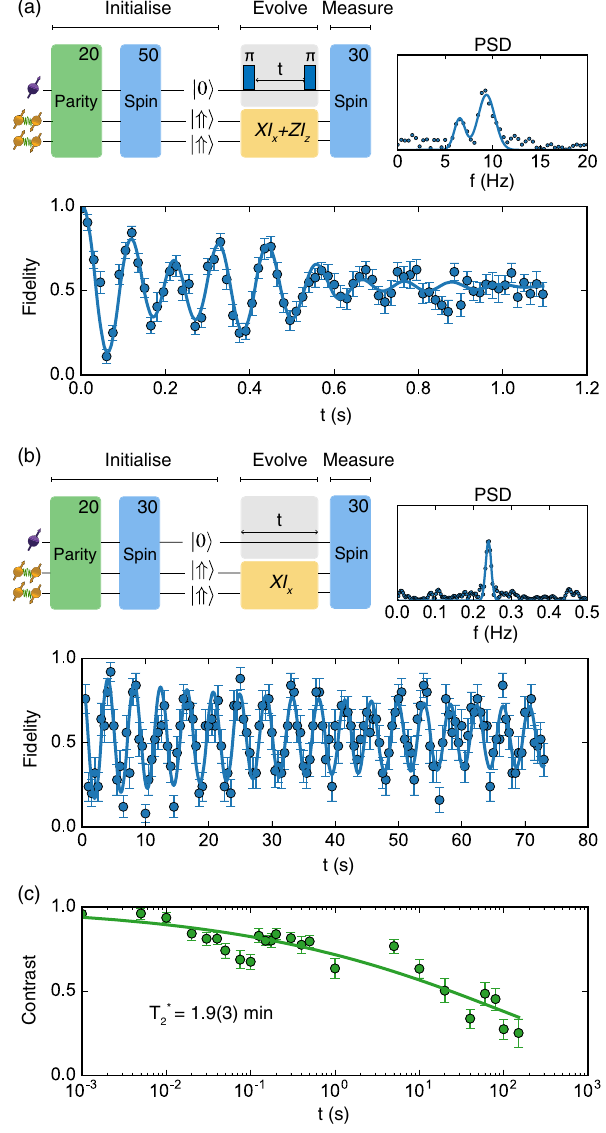
FIG. 3. Coherence of pairs A and B . (a) Ramsey measurement with the NV in m s ¼ − 1 . Top left: experimental sequence. Top right: Fourier transform of the signal indicating two frequencies. From the data, we obtain the coupling of the pairs to the NV: Z 130 ð 1 Þ Hz and Z 91 ð 2 Þ Hz. (b) Ramsey measurement A ¼ B ¼ with the NV in m s ¼ 0 . Top left: experimental sequence. Top right: Fourier transform indicating a single frequency. From the data, we obtain X ¼ 2080 . 9900 ð 3 Þ Hz. For (a) and (b), a detuning is applied (Appendix B). (c) Each data point corre- sponds to the amplitude of a Ramsey measurement in m s ¼ 0 . A fit yields T (cid:1) 2 ¼ 1 . 9 ð 3 Þ min; see Appendix B. The data deviate from a simple exponential decay, indicating that processes beyond pure dephasing contribute to decoherence (Supplemental Sec. I [38]). The error bars represent one standard